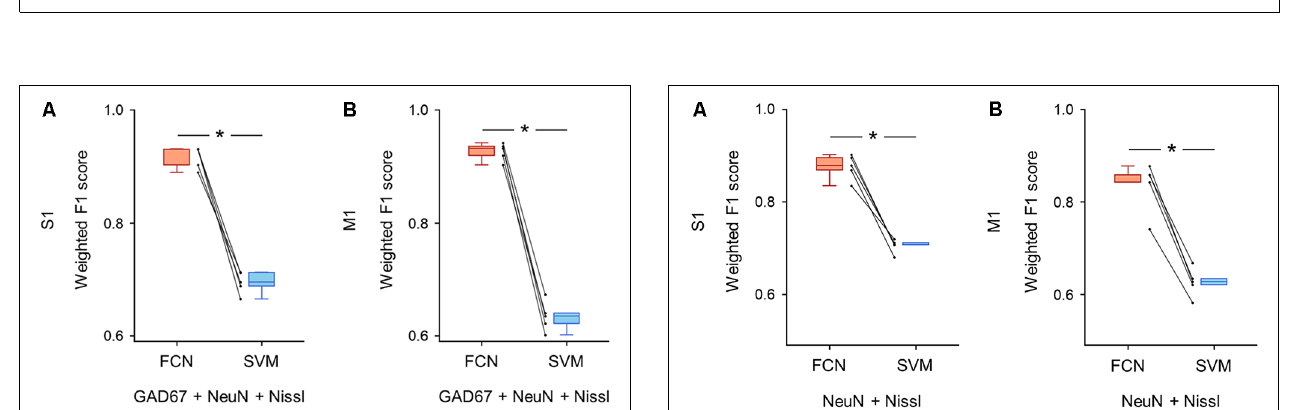
FIGURE 4 | Fully convolutional network architecture. The current model processes input cell images (leftmost) in multiple layers and outputs the results of the binary classification (rightmost). The numbers (bottom) imply the channel features in each layer; note that N represents the number of fluorescence channels and thus ranges from 1 to 3. Abbreviation: conv, convolutional layer.